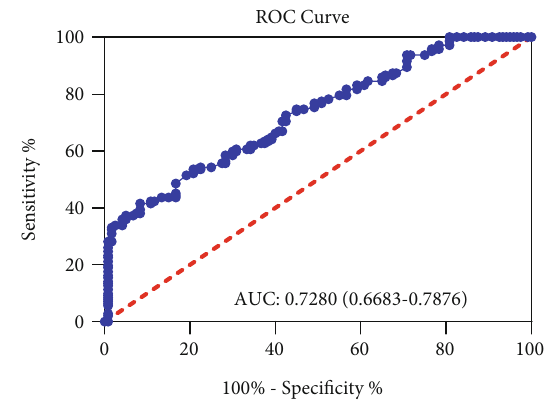
Figure 1: ROC curve analysis for in-hospital peak glycemia for prediction of no-re fl ow phenomenon after pPCI in patients with STEMI combining with